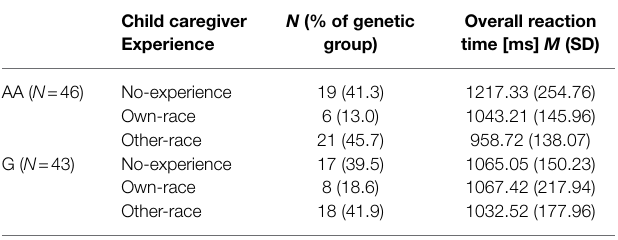
TABLE 1 | Distribution of the samples in the two genetic groups and types of early child caregiver experience. Child caregiver Experience